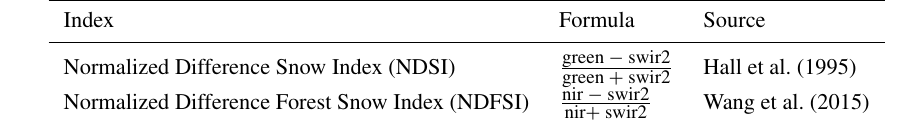
Table 5. Vegetation indices used to detect snow cover from optical and multispectral imagery.